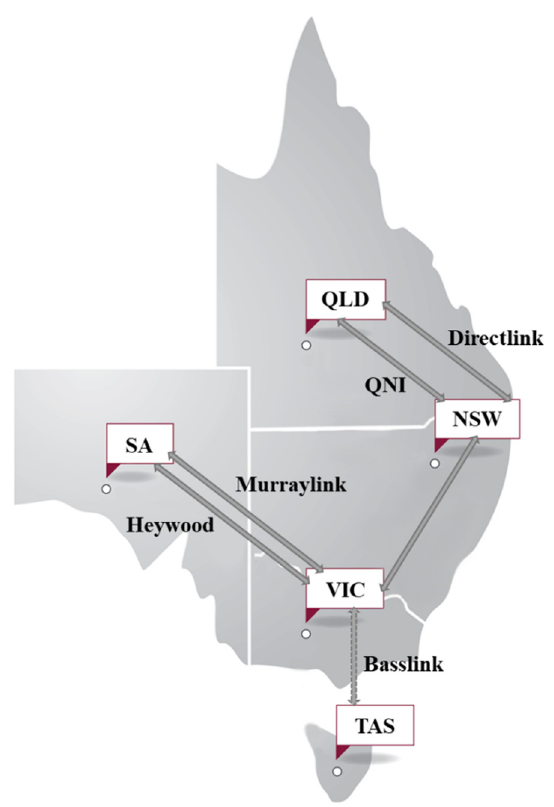
Figure 1. A depiction of Australia’s National Electricity Market (NEM), showing the five distinct regional markets and key transmission interconnectors between regions.